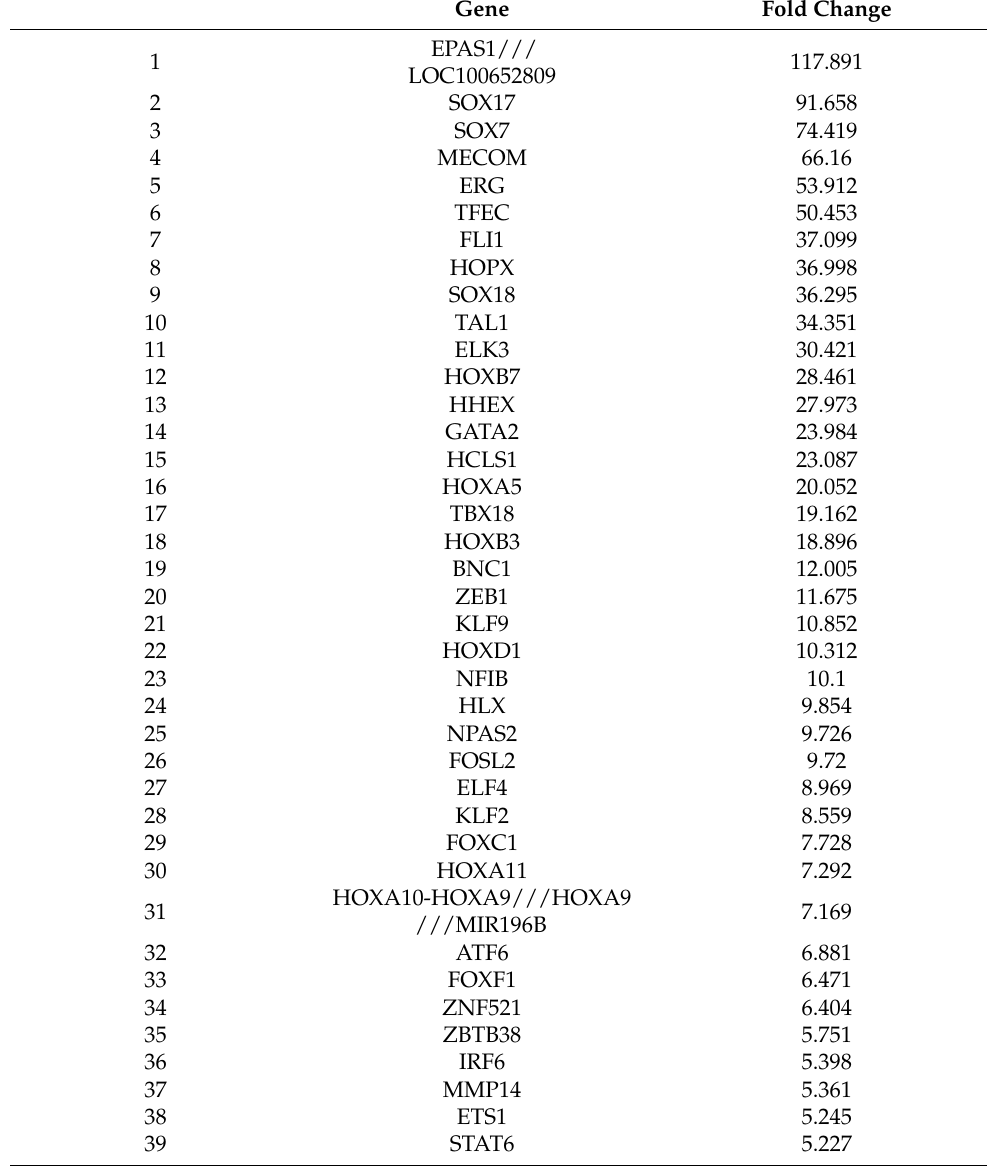
Table 3. Genes in transcription factor category that are upregulated in endothelial